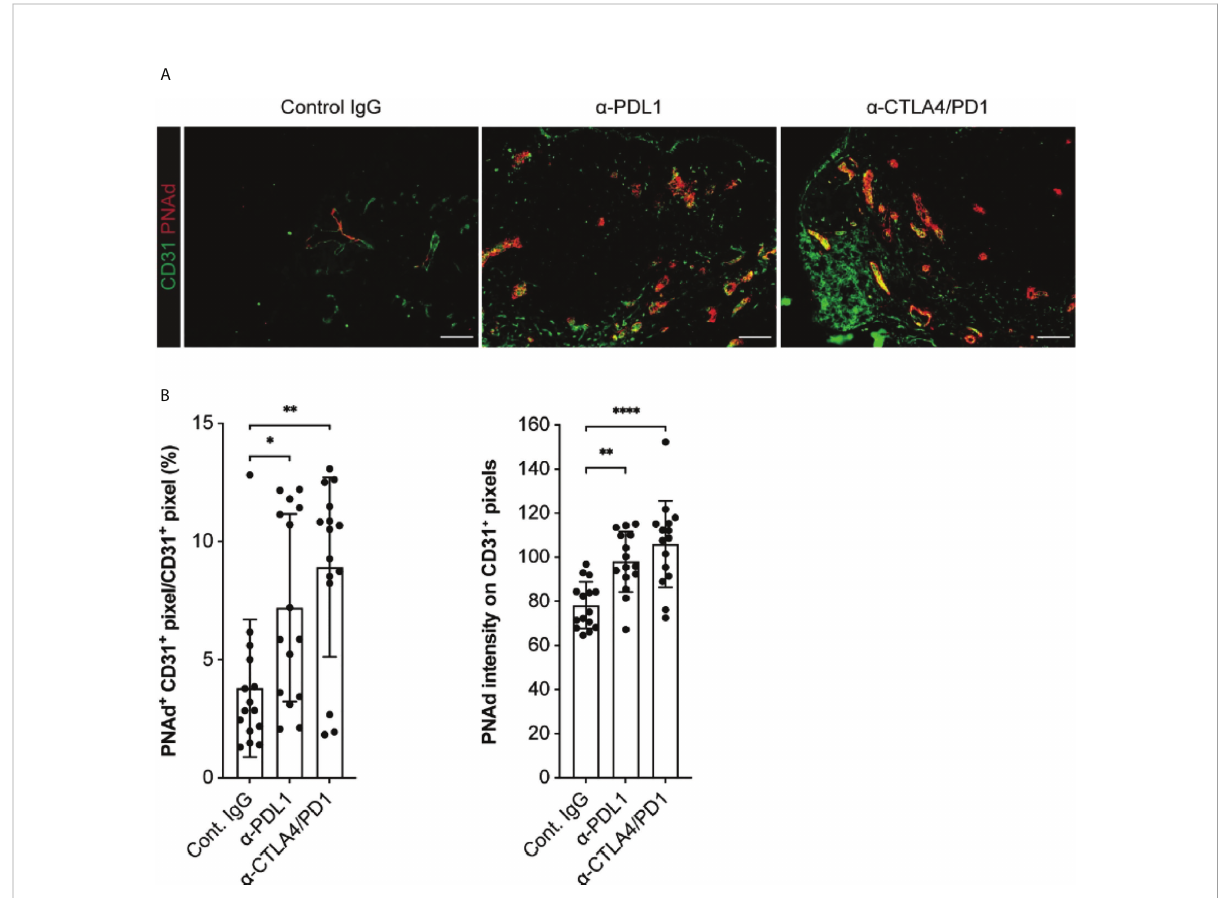
FIGURE 8 Checkpoint immunotherapy augments PNAd expression on I.P. tumor vasculature. C57BL/6 mice were I.P. injected with B16-OVA cells and tumor- bearing mice were treated with control IgG, anti-PDL1, or anti-CTLA4/PD1 beginning 3 days after implantation. Tumors were harvested 14 days after implantation and prepared for IF as described in Methods. (A) Representative images of tyramide signal ampli fi ed tumor sections stained with indicated markers. Scale bar = 100 µm. (B) Quantitative image summary data for ampli fi ed tissue sections. PNAd percentages and pixel intensities were calculated on a CD31 + mask. Data represents three experiments, n = 15 individual sections per group. (B) Results are mean ± SD analyzed by unpaired Welch ’ s t-test. *p<0.05, **p<0.01, and ****p<0.0001, all other paired bar comparisons are not signi fi cant (p>0.05) and have been omitted for